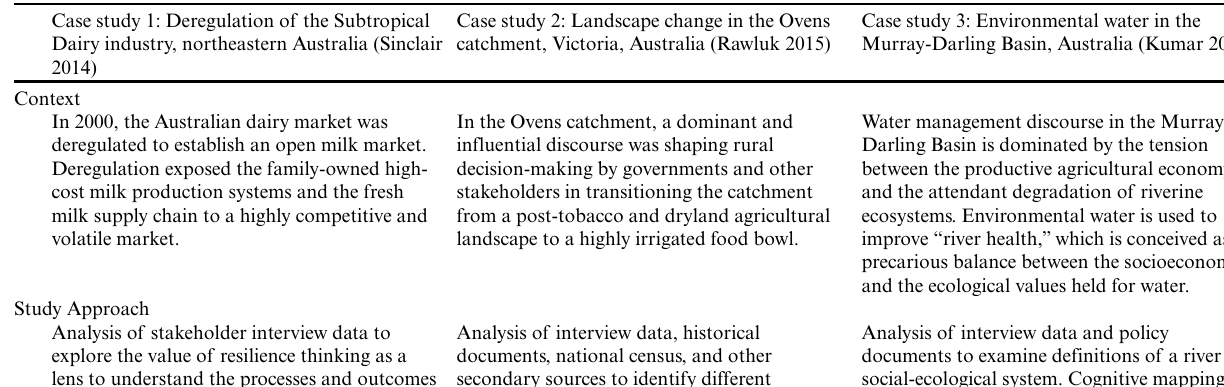
Table 1 . A summary of the three case